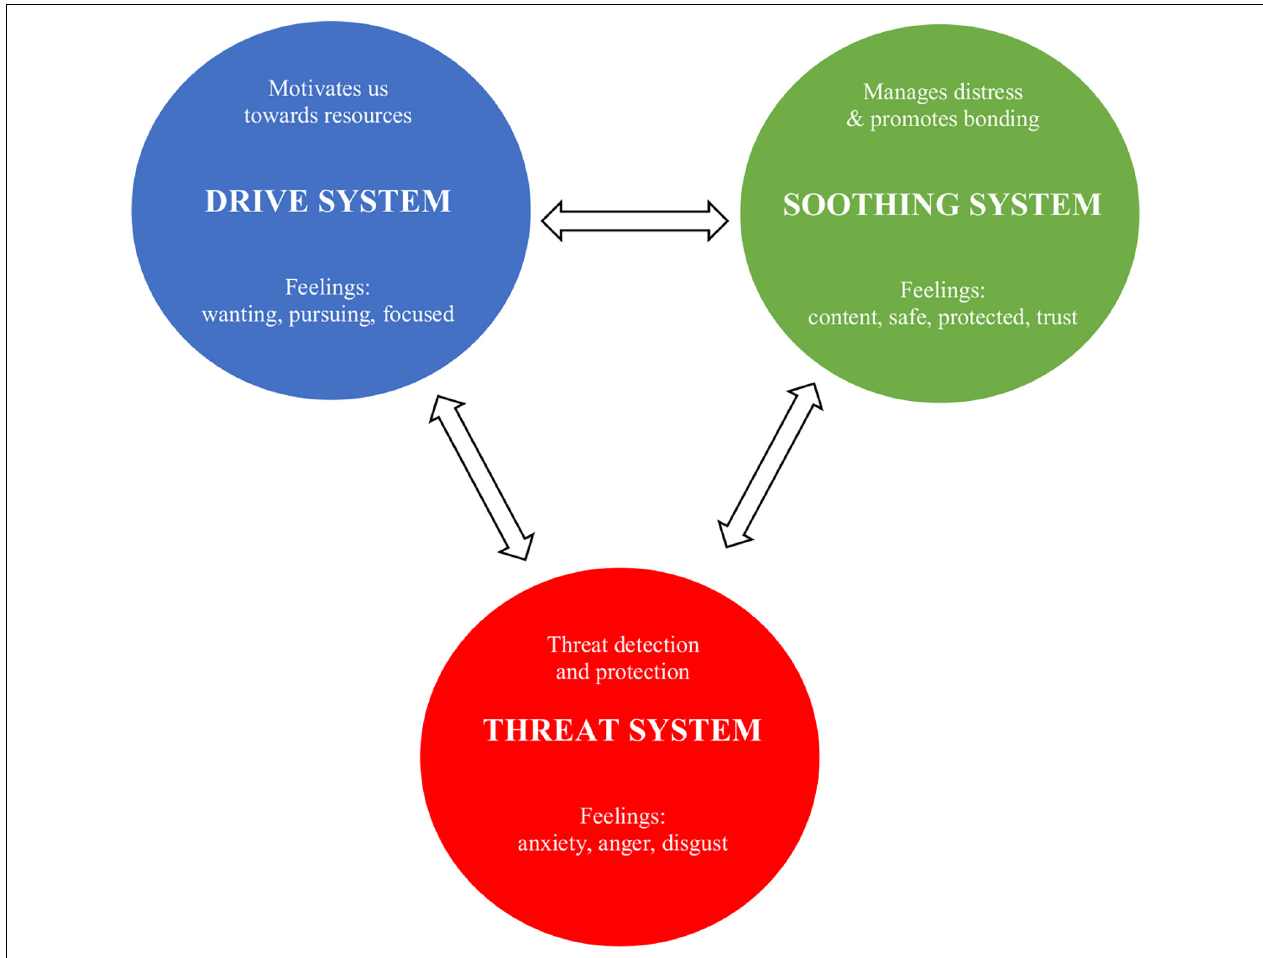
FIGURE 1 | Three types of CFT emotion regulation